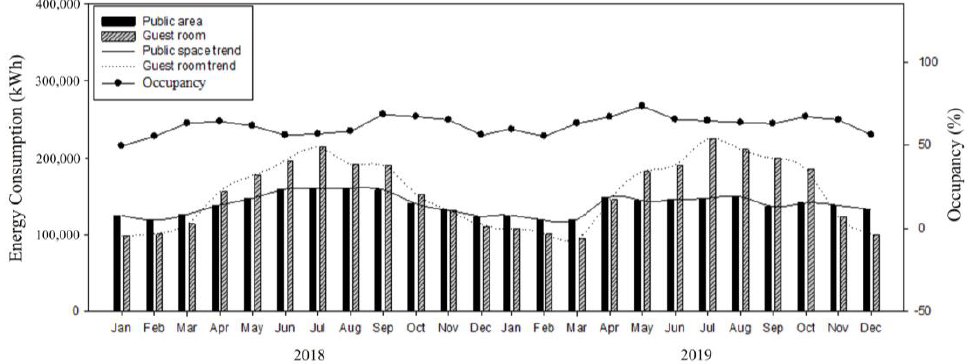
Figure 5. Energy consumption in different areas and occupancies.